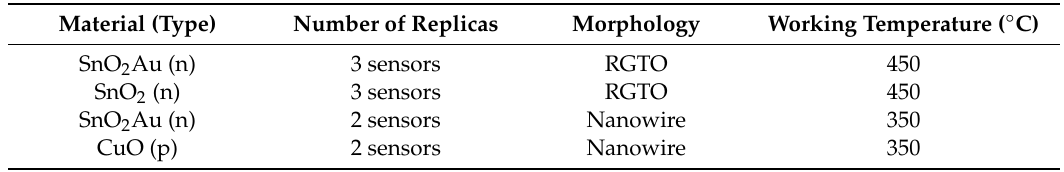
Table 1. List of the ten sensors used in the